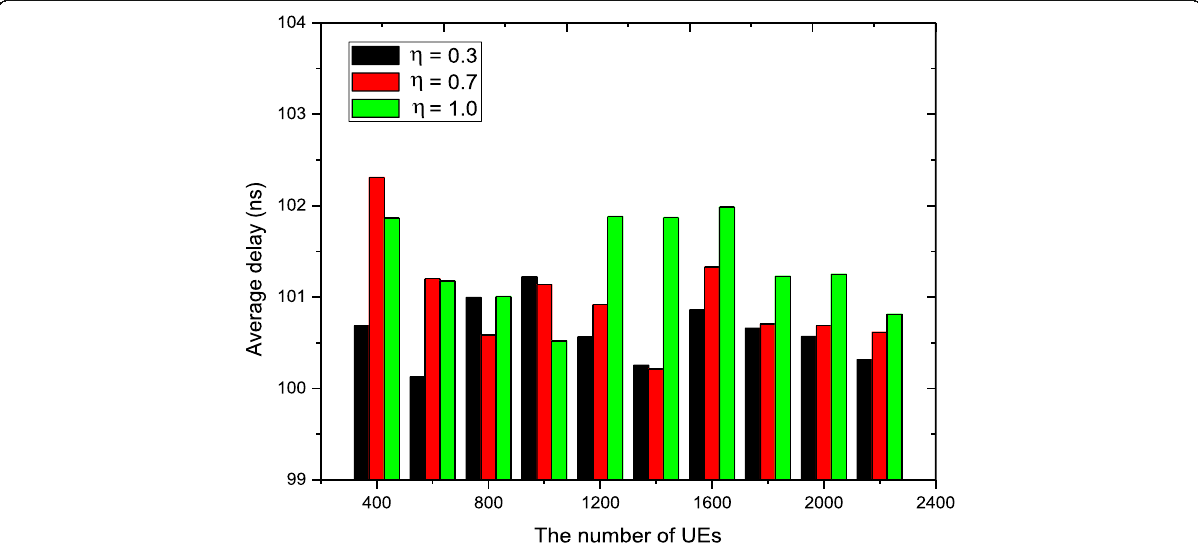
Fig. 11 Average delay for the DTO-MROD scheme under the different typical values for